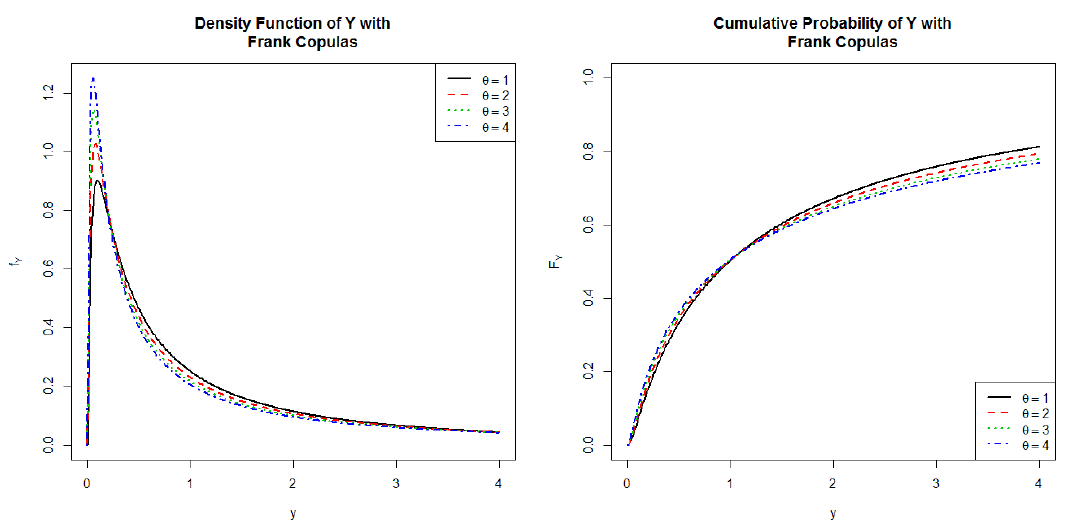
Figure 5. PDFs and CDFs of the product of two log-normal distributed random variables having Frank Copulas.